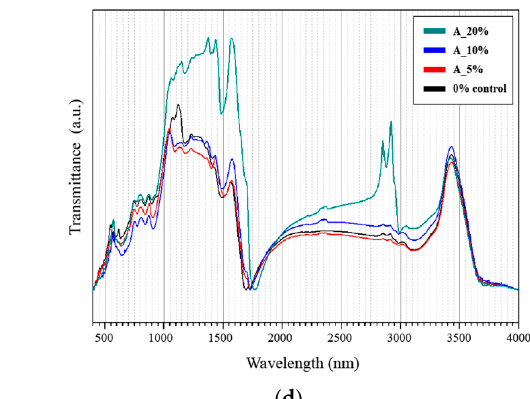
Figure 4. FT-IR results for ( a ) 5%, ( b ) 10%, and ( c ) 20%-NaCl biochar after and before washing, with the results for 0%-NaCl biochar. ( d ) FT-IR results for 0%, 5%, 10%, and 20%-NaCl biochar after washing.